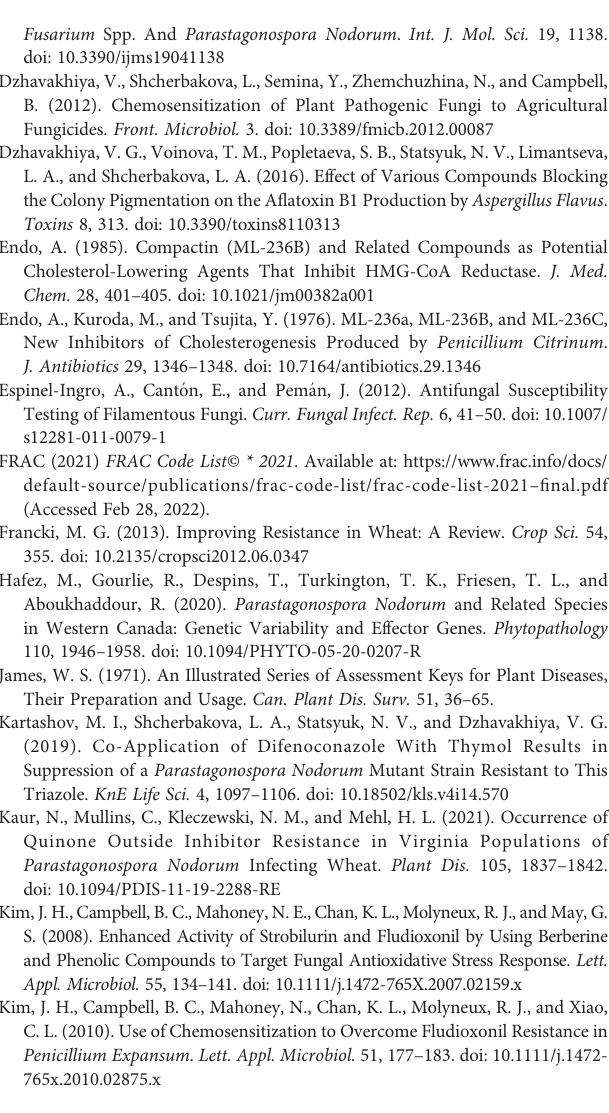
Supplementary Table 1 | The levels of minimum inhibitory concentrations (MIC) * of 6-demethylmevinolin (6-DMM) and fungicides for wild P. nodorum strains (M-4 and 8/B-47) as well as for tebuconazole- and azoxystrobin-resistant mutants (m8-4 and kd-18, respectively) * MIC is the lowest concentration preventing a visible colony growth. The MIC values were detected by serial dilutions according to a reference CLSI method for antifungal susceptibility testing of fi lamentous fungi (Espinel-Ingro et al., 2012) and also calculated using a probit